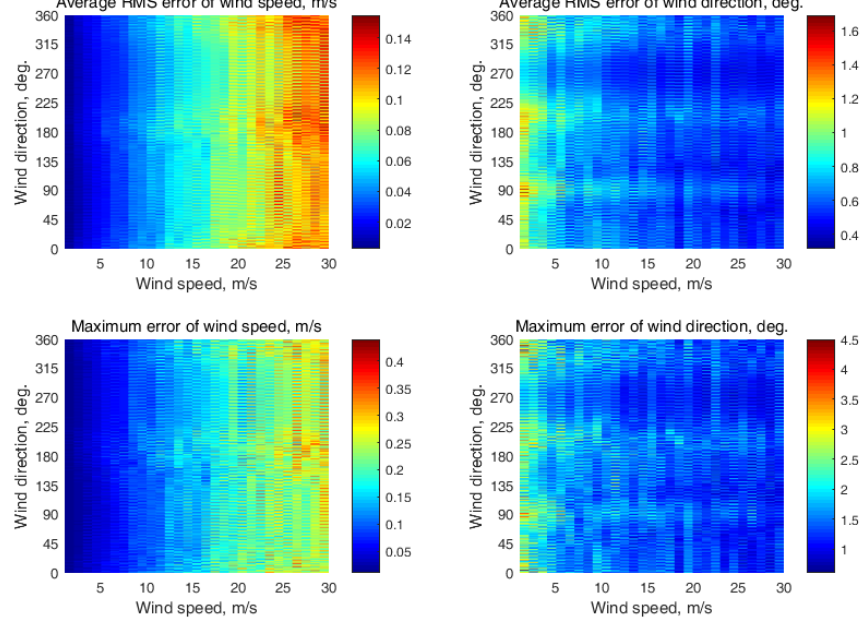
Figure A17. Semicircular wind retrieval results at the (40°, 45°, 50°) incidence angle combination.